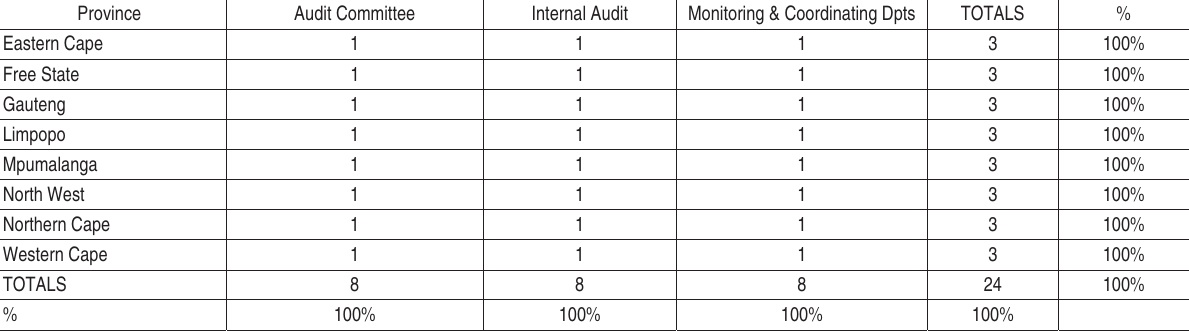
Table 1. Second level